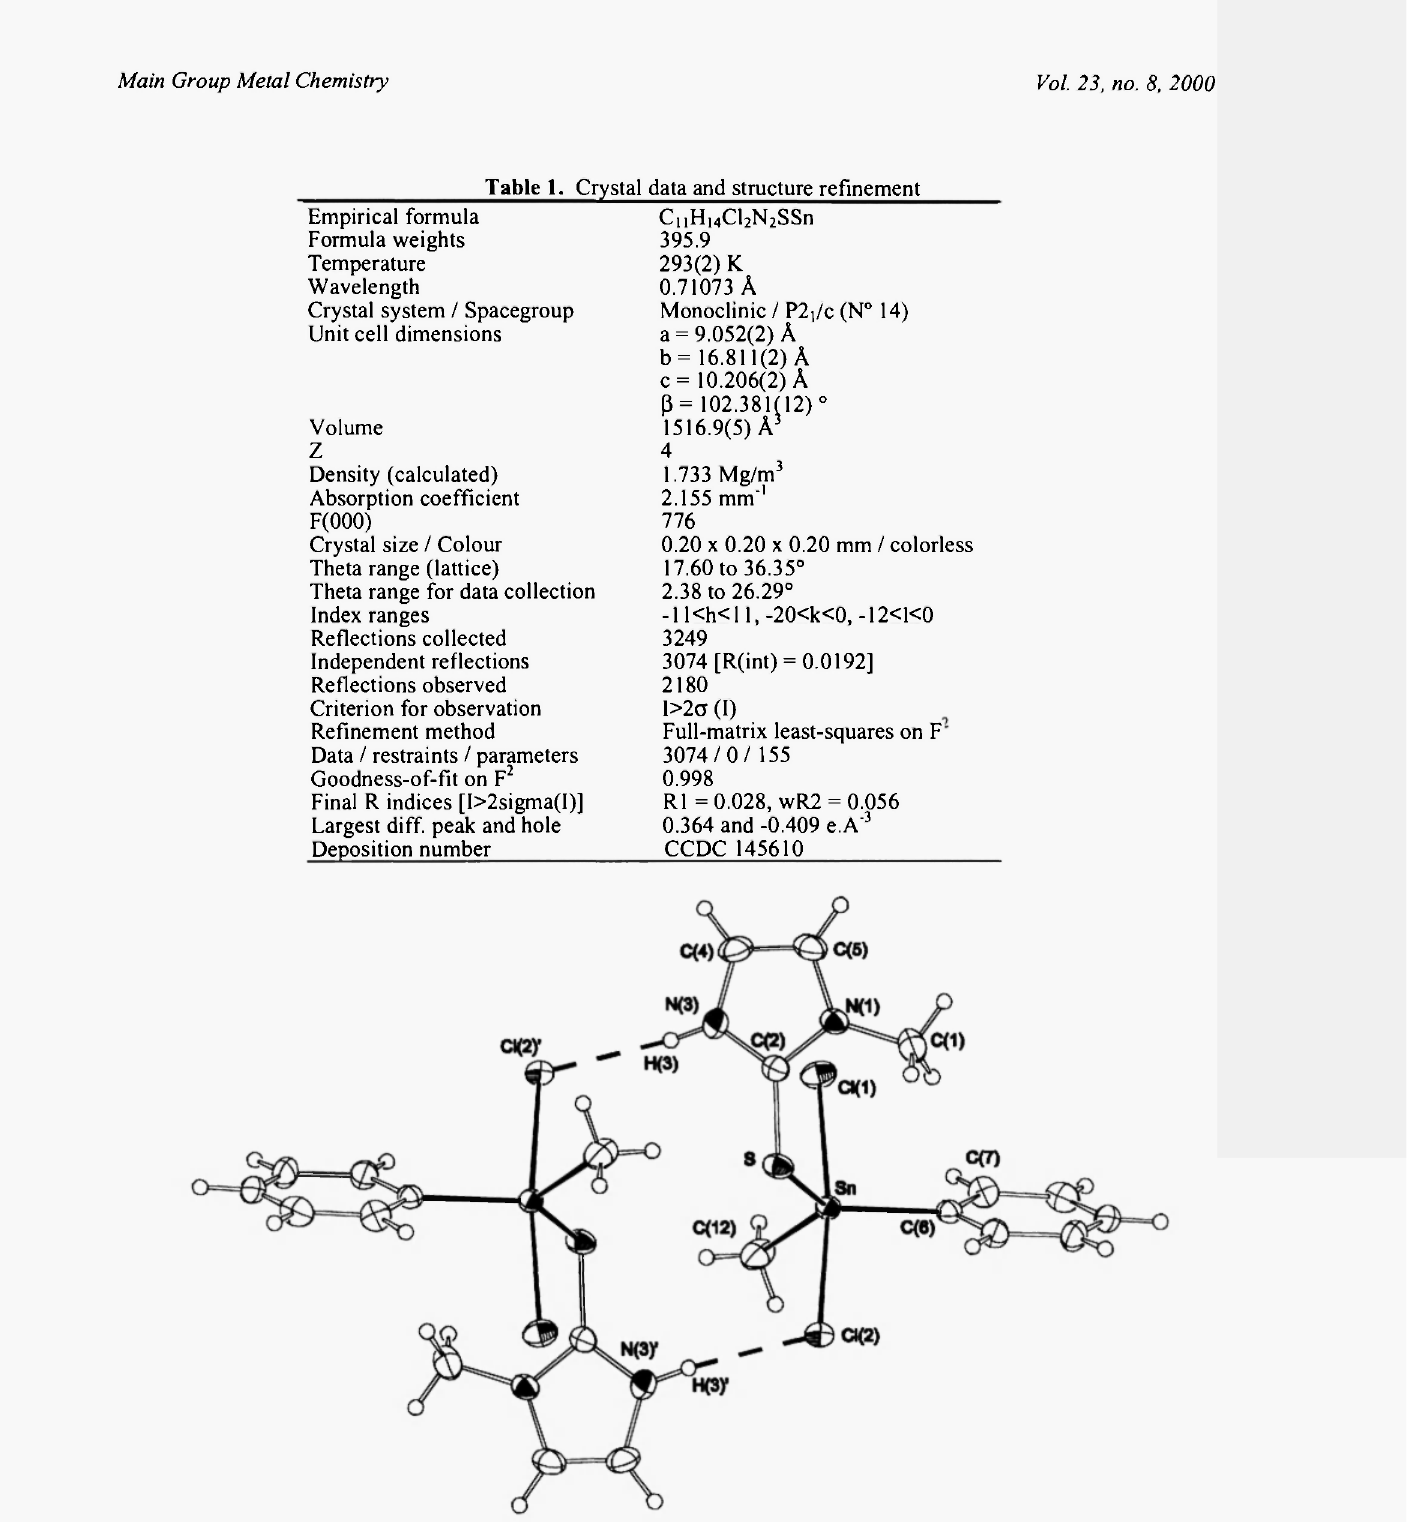
Table 1 . Crystal data and structure refinement